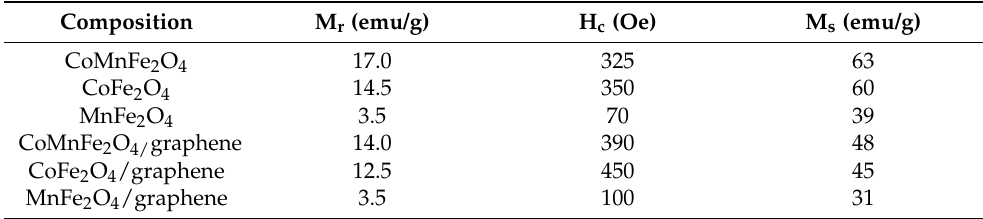
Figure 5. Magnetic hysteresis loops of the prepared ferrite/graphene composite. The values of remnant magnetization M r , coercivity H c , and saturation magnetization M s are recorded in Table 2. Table 2. Remnant magnetization M r , coercivity H c , and saturation magnetization M s of the investi- gated samples.